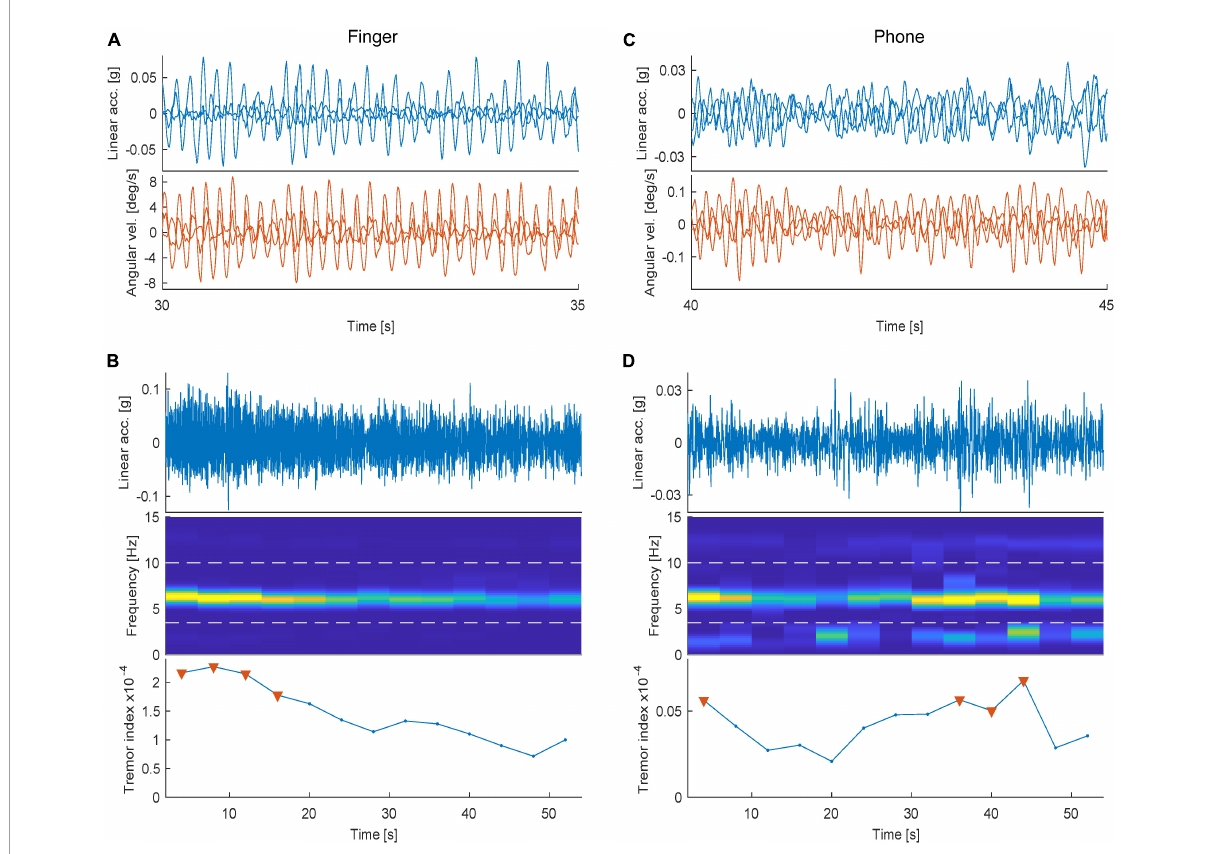
FIGURE1 Data processing steps used to create tremor scores. (A) , Example raw traces illustrating postural tremor recorded using a high-resolution inertia sensor attached to the index finger. Each line in the two plots illustrates an independently recorded dimension (Top panel: Linear acceleration and Bottom: Angular velocity). (B) (Top) Example, one-minute recording of one of the channels shown in panel (A) . (Middle) Spectrogram illustrating the relative power spectral density for frequencies < 15 Hz, binned in 4s-windows. (Bottom) Calculated tremor index plotted over time [triangles denote the period (top 33%) used to construct a single tremor score]. (C,D) The corresponding data sampled from the smartphone (in the same subject recorded directly